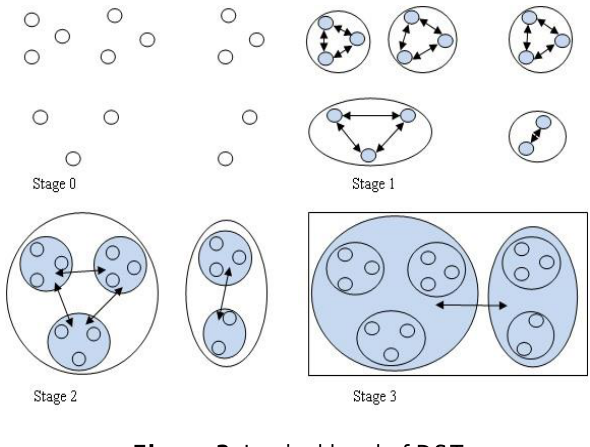
Figure 3. Logical level of